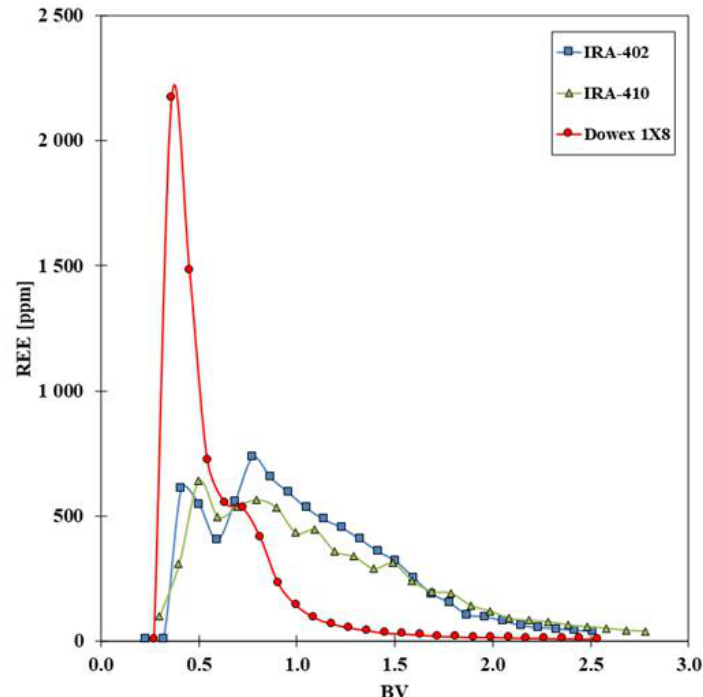
Figure 2. Chromatograms for REE elution with Dowex 1X8, IRA-410 and IRA-402 (T = 298 ± 2 K; flowrate = 2.98 BV/h; feed pulse = 0.025 BV, Eluent = 10 mM HNO 3 ; Feed solution = #2).